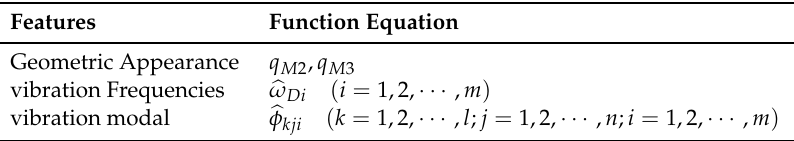
Table 2. The features used for the detection of collisions.